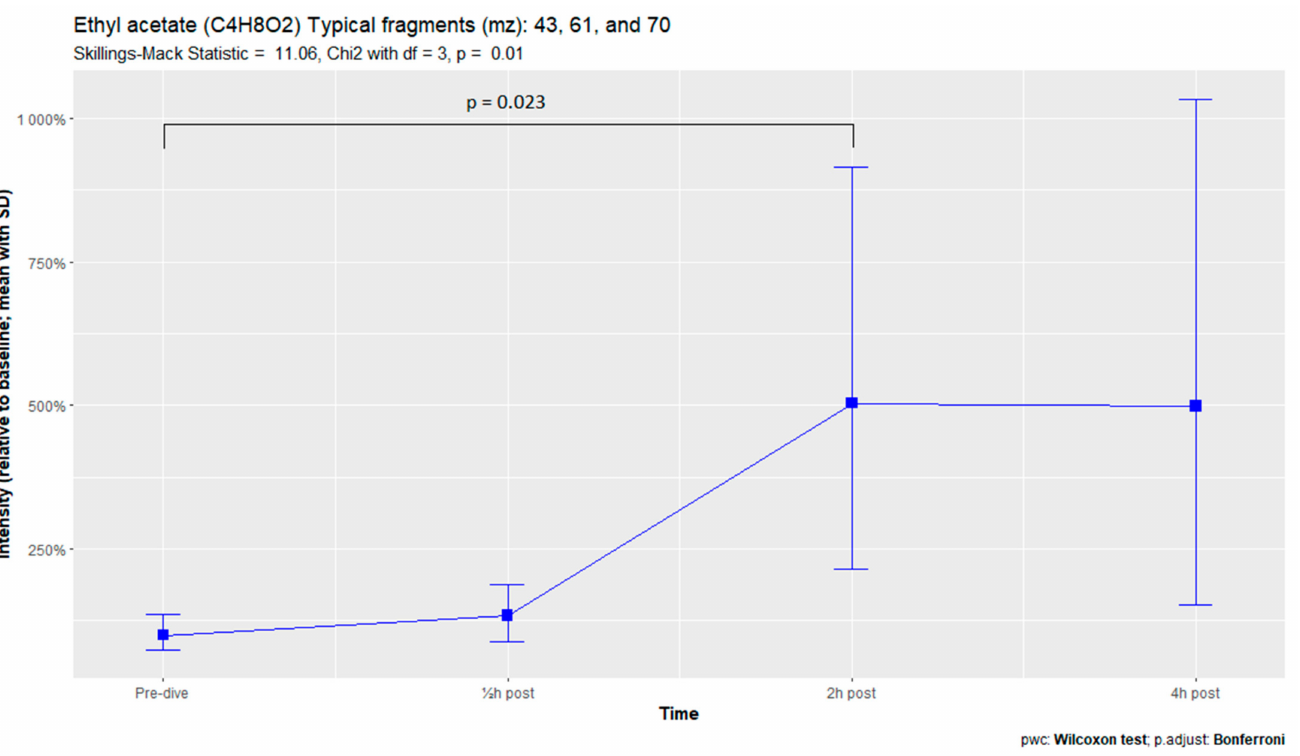
Figure A2. Ethyl